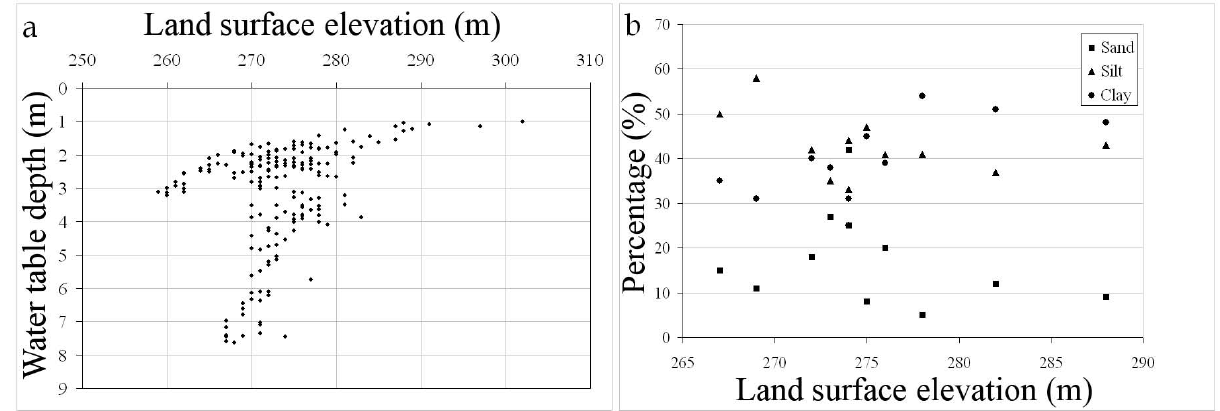
Fig. 6. The relationship between land surface elevation and both (a) the water table depth and (b) the soil texture of the collected samples.